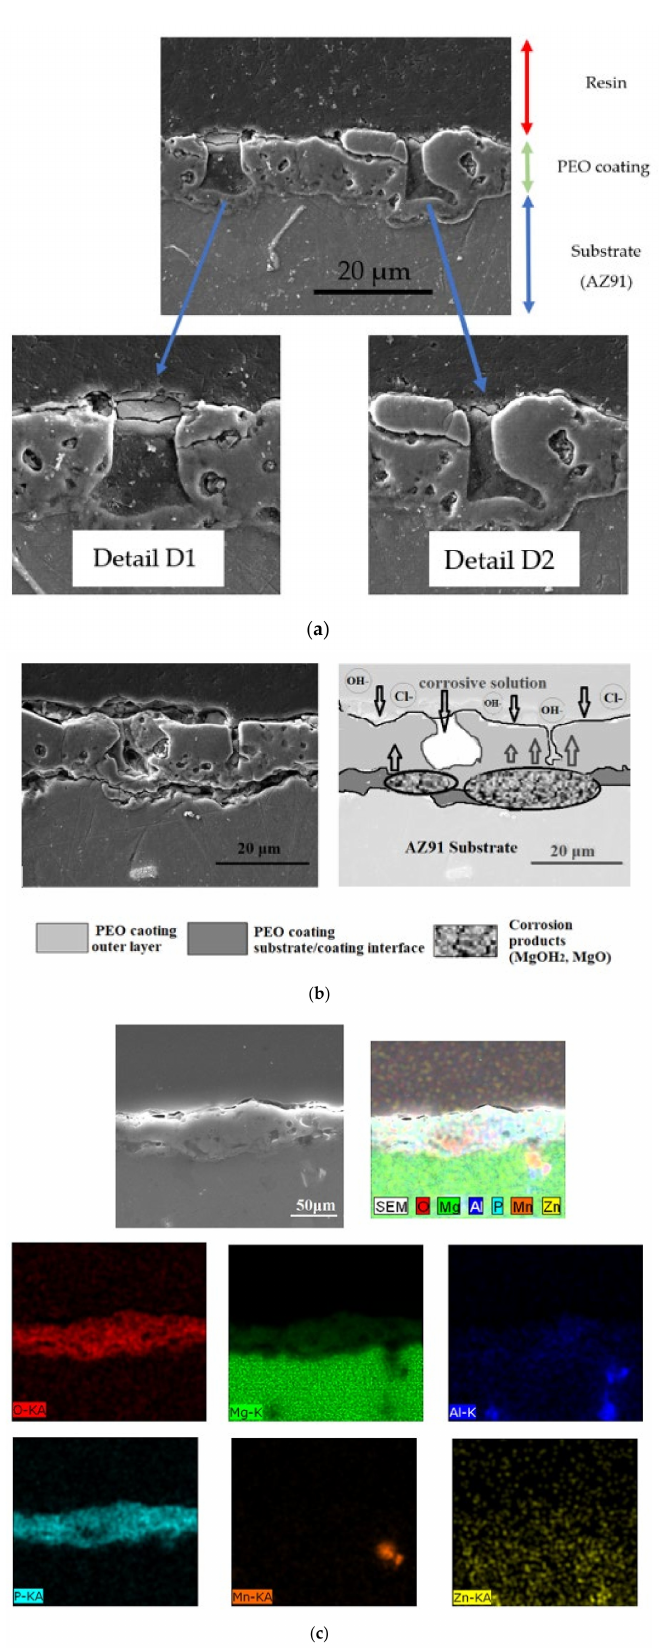
Figure 4. SEM images of PEO coating ( a ) cross-section of interfaces with microstructural defects, ( b ) sub- strate/coating interface together with principal corrosion product formation, ( c ) EDX analysis of PEO